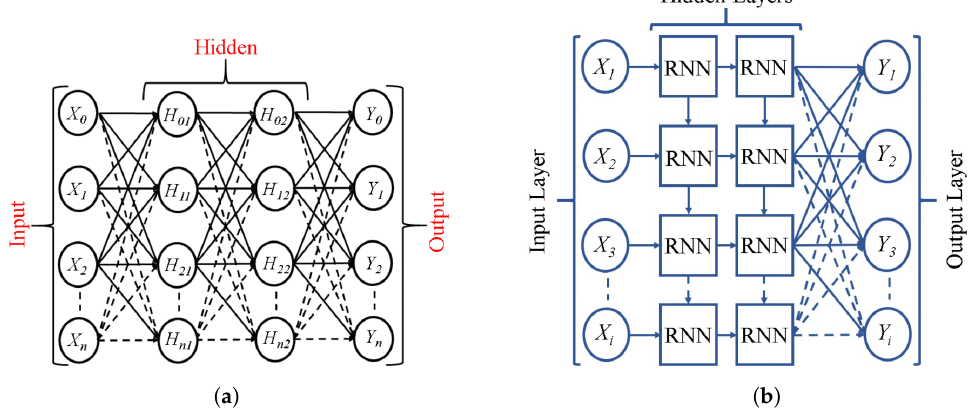
Figure 2. ANN and RNN Blocks Techniques. ( a ) ANN Block. ( b ) RNN